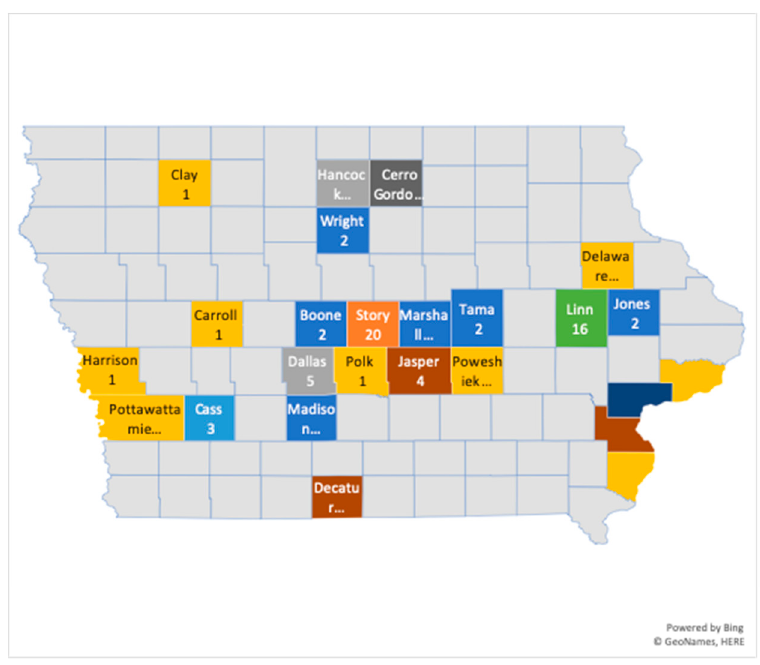
Figure 1. Iowa map illustrating number of water samples collected from counties in 2017 − 2018.